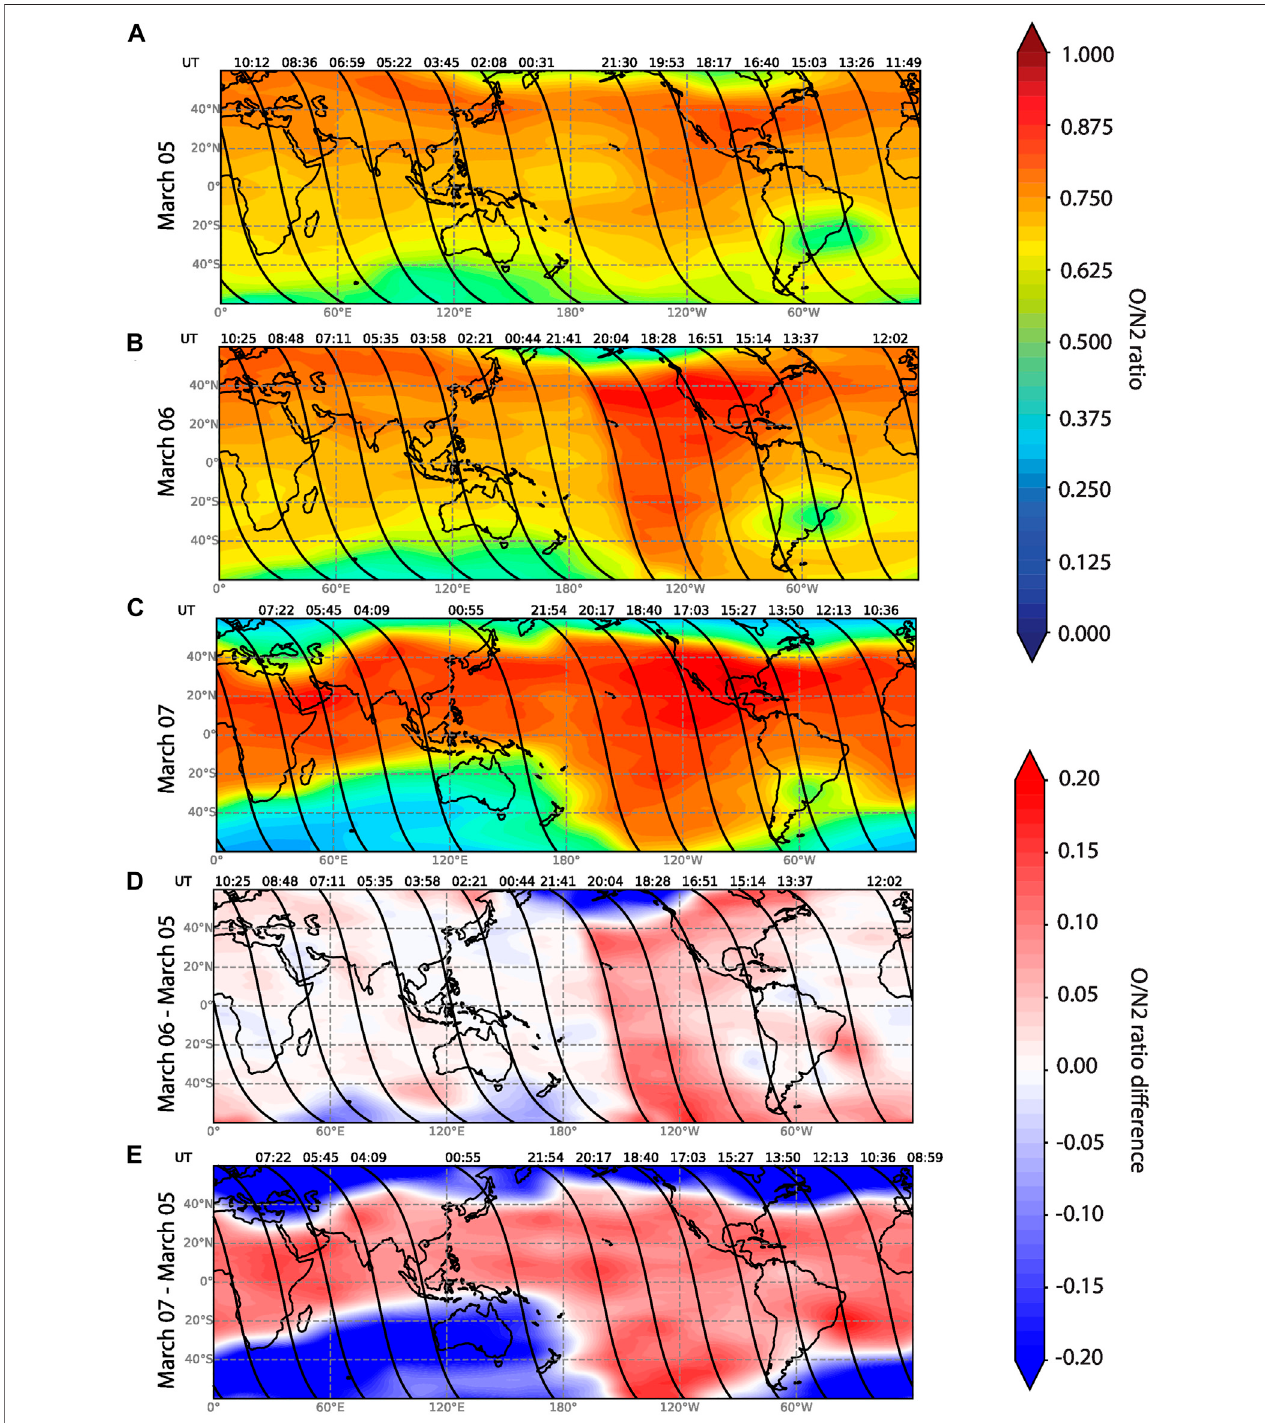
FIGURE 4 | The TIMED GUVI O/N 2 ratio of March 05 – 07 are shown in panels (A – C) in geographic coordinates. The quiet time O/N 2 values on March 05 were subtractedfromthestormdayvaluesandthedeltaO/N 2 areplottedinpanels (D – E) .Ineachpanel,thetrajectoriesoftheTIMEDsatelliteareshownandtheUTswhenthe satellite crossed the 60 ° latitude in the Northern Hemisphere are labeled at the top horizontal axis.